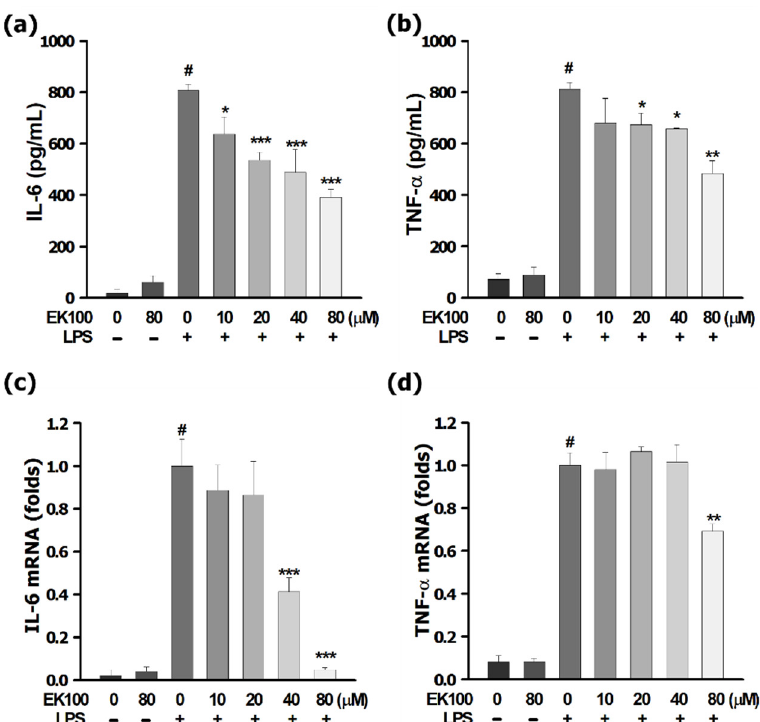
Figure 1. EK100 inhibited IL-6 and TNF- α released in LPS-stimulated RAW 264.7 cells. RAW 264.7 cells were treated with 0, 10, 20, 40, and 80 µM EK100 for 1 h before being stimulated with 100 ng/mL LPS for 24 h. Then the suspension media was separated from the remaining cells. In the suspension media, we detected the cytokines productions of IL-6 ( a ) and TNF- α ( b ) by using the specific ELISA kit, respectively. It extracted and analyzed IL-6 ( c ) and TNF- α ( d ) mRNA in the remaining cells by using q PCR assay as described in Materials and Methods. Data are presented as the means ± SEM of three independent experiments ( n = 3). # p < 0.05 compared to the control group, * p < 0.05, ** p < 0.01, and *** p < 0.001 compared to LPS alone group.